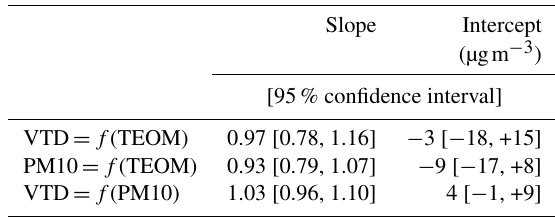
Table D1. Optimal slope and intercept using orthogonal regres- sions, including the heavy loaded sample.